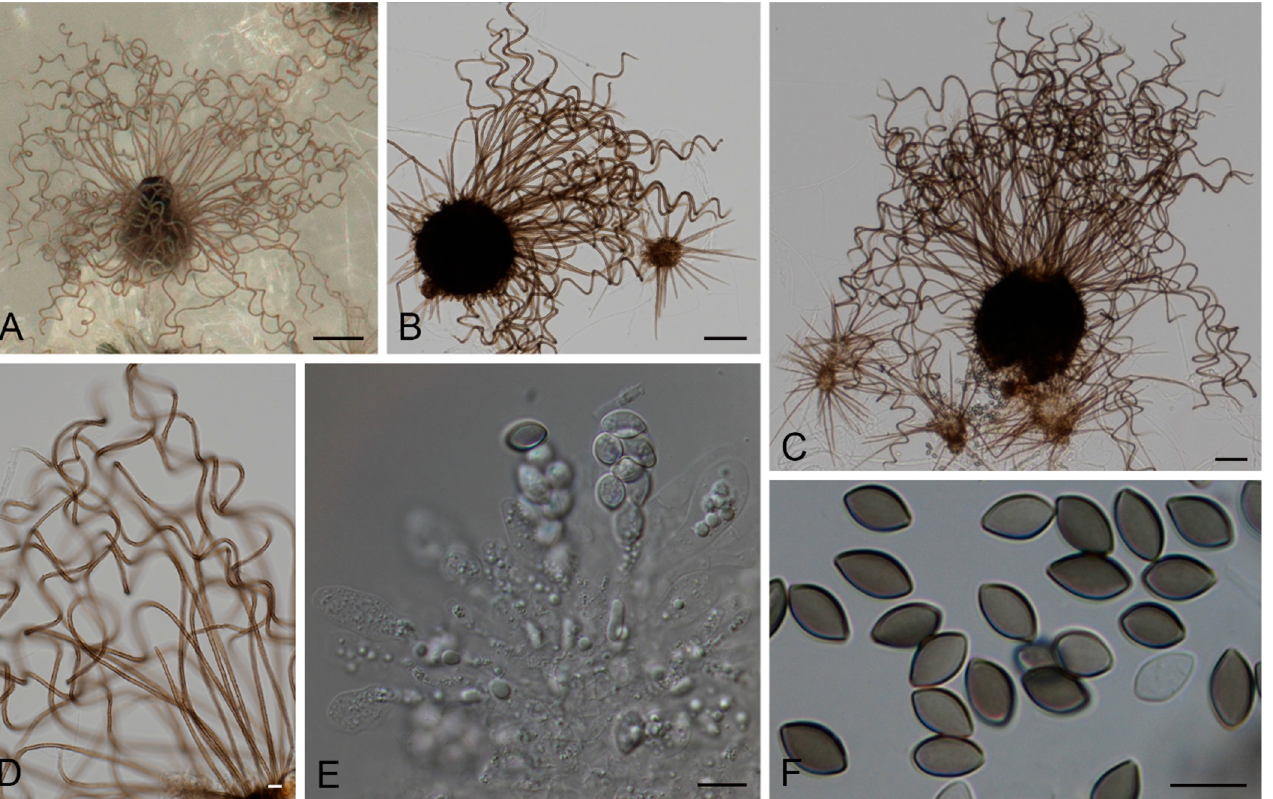
Figure 2. Amesia hispanica sp. nov. (CBS 149852). ( A – C ). Ascomata. ( D ). Terminal ascomatal hairs, ( E ). Asci. ( F ). Ascospores. Scale bars: ( A ) = 100 µm; ( B , C ) = 50 µm; ( D – F ) = 10 µm.